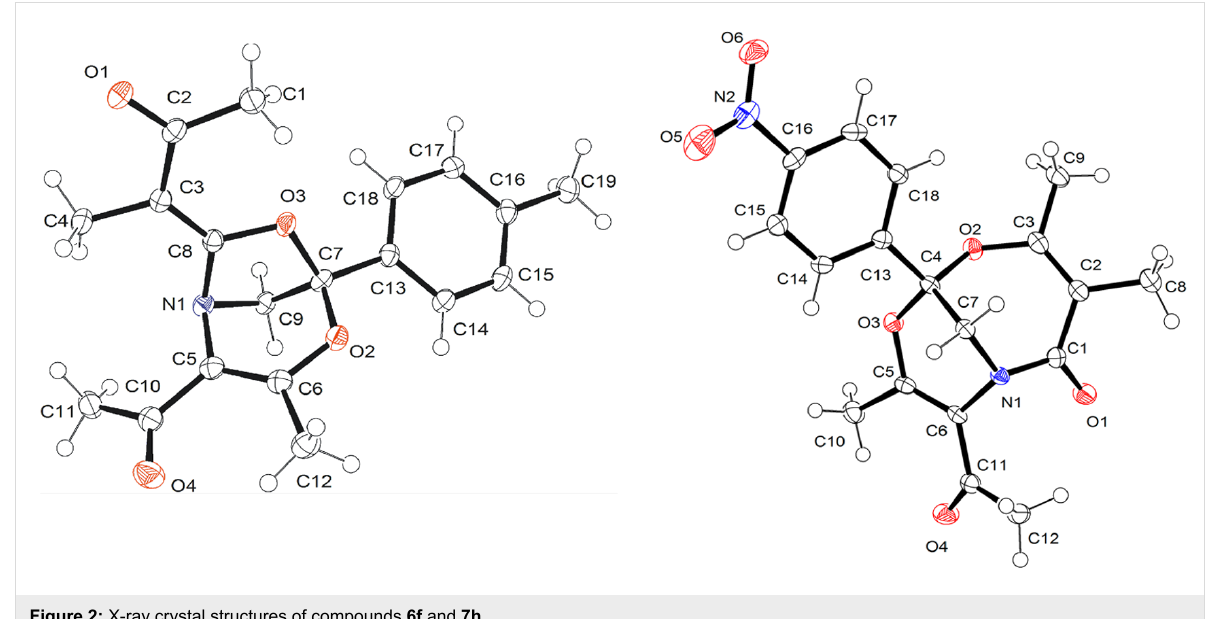
Figure 2: X-ray crystal structures of compounds 6f and 7h .